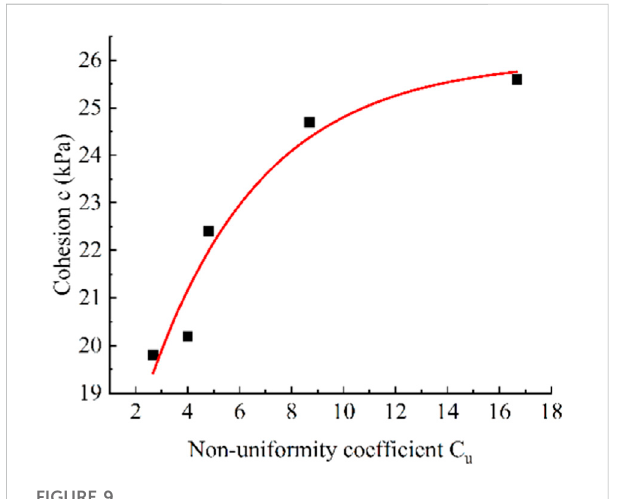
FIGURE 9 Fitted relationship curve between Cu and cohesion.